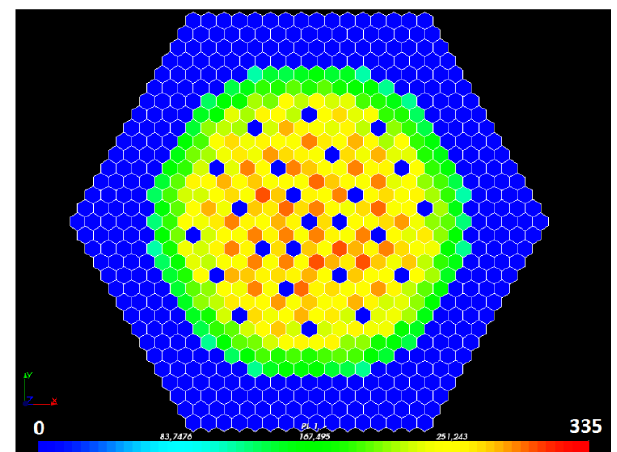
Fig. 3. Linear power distribution (W/cm by pin) in the center of the core at end of cycle.